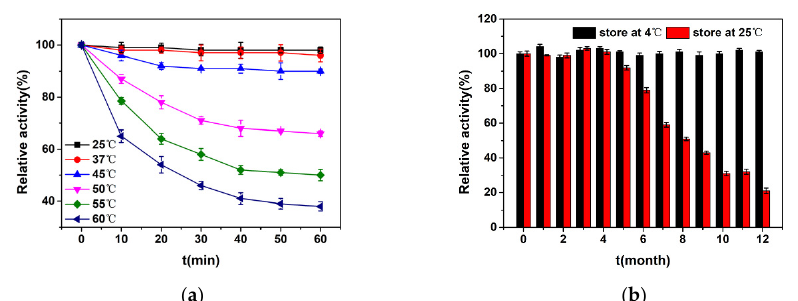
Figure 2. ( a ) Thermostability test of CmAP. 1 μ g/mL CmAP solutions were incubated at temperatures ranging from 25 ◦ C to 60 ◦ C at pH 7.0 for 1 h. Then, the relative activity of each sample was